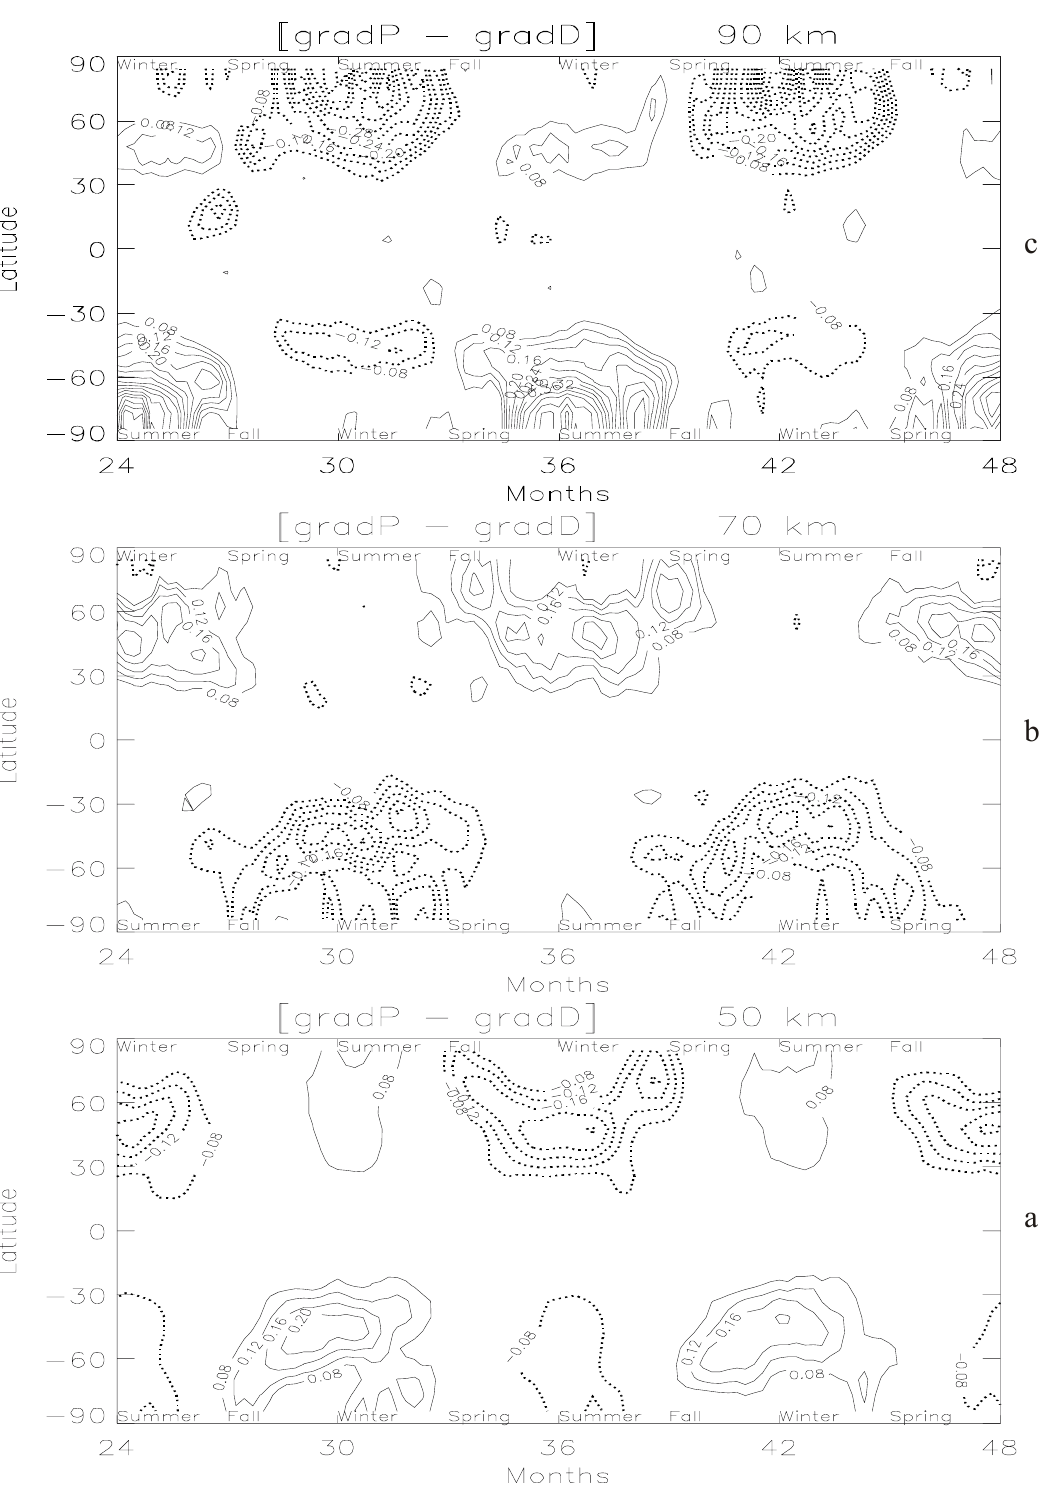
Fig. 9. Contour plots of the difference between the relative latitude gradients of pressure and density for m=0, which represents a measure of baroclinity. To reduce clutter, the lowest contours (0.04) are suppressed. At 50km ( a ) , the normalized pressure gradients are larger than the density gradients during the winter season, having opposite signs in the two hemispheres. But at 70km ( b ) , the density gradients are larger in winter, which is due to the GW driven reversal in the latitudinal temperature variation. At 90km ( c ) , the latter causes the largest gradients to develop in